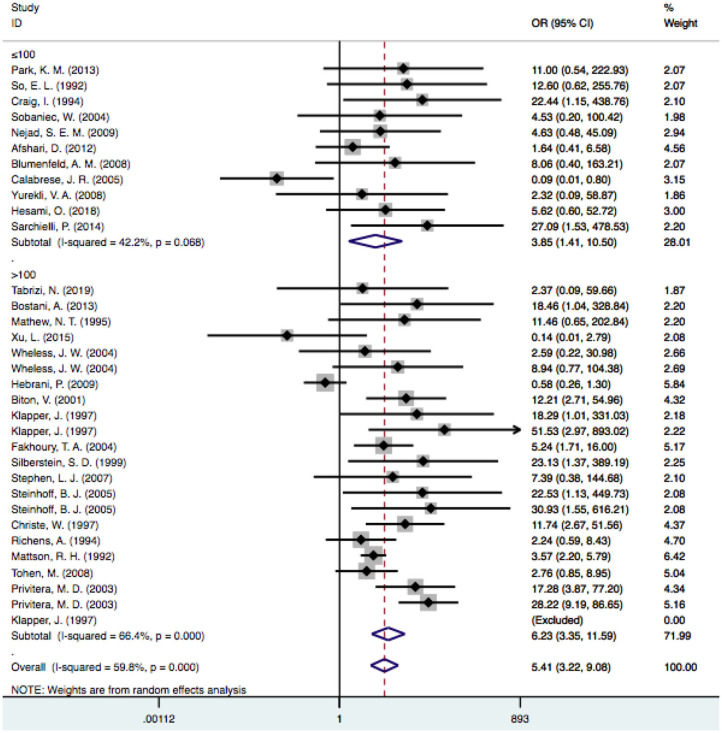
Subgroup analysis of VPA-associated tremor compared with other drugs according to the sample size. VPA, valproic acid.